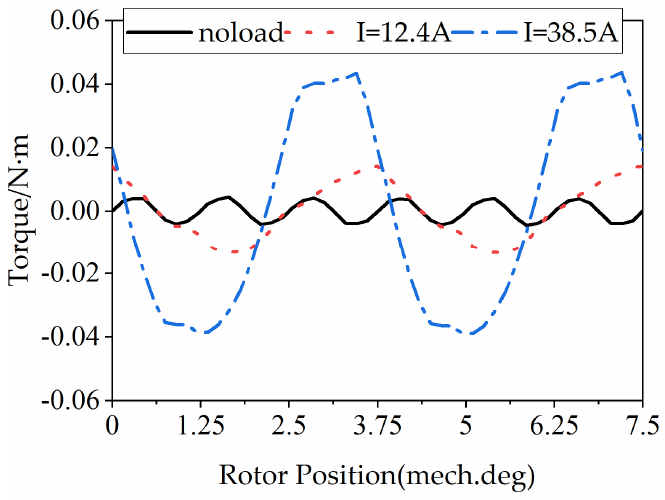
Figure 9. Comparison of cogging torque and load torque fluctuation components.